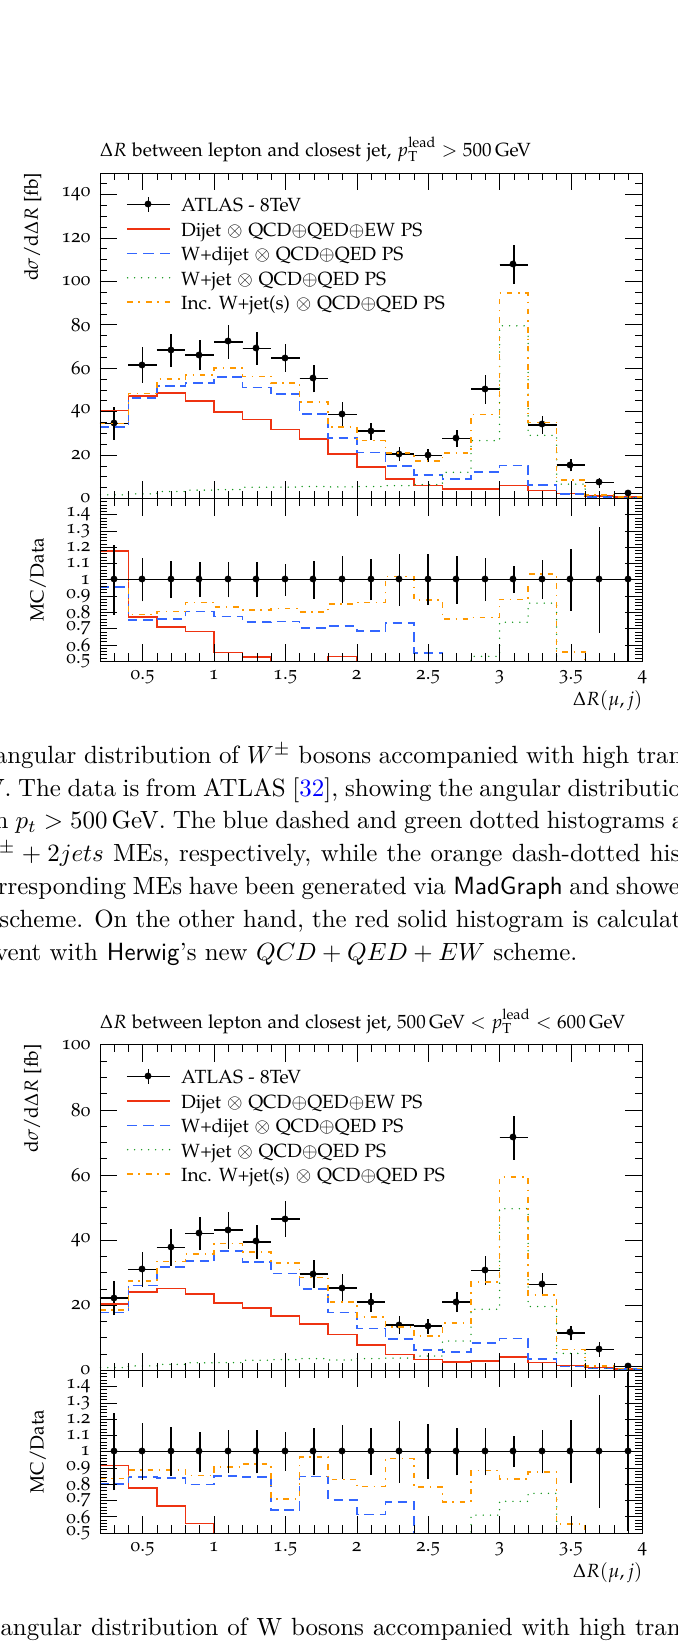
Figure 14. The angular distribution of W bosons accompanied with high transverse momentum √ jets at s = 8 TeV. The data is from ATLAS [32], showing the angular distribution of the muon and the closest jet with 500 GeV < p t < 650 GeV . The notation of the plot is the same as in figure